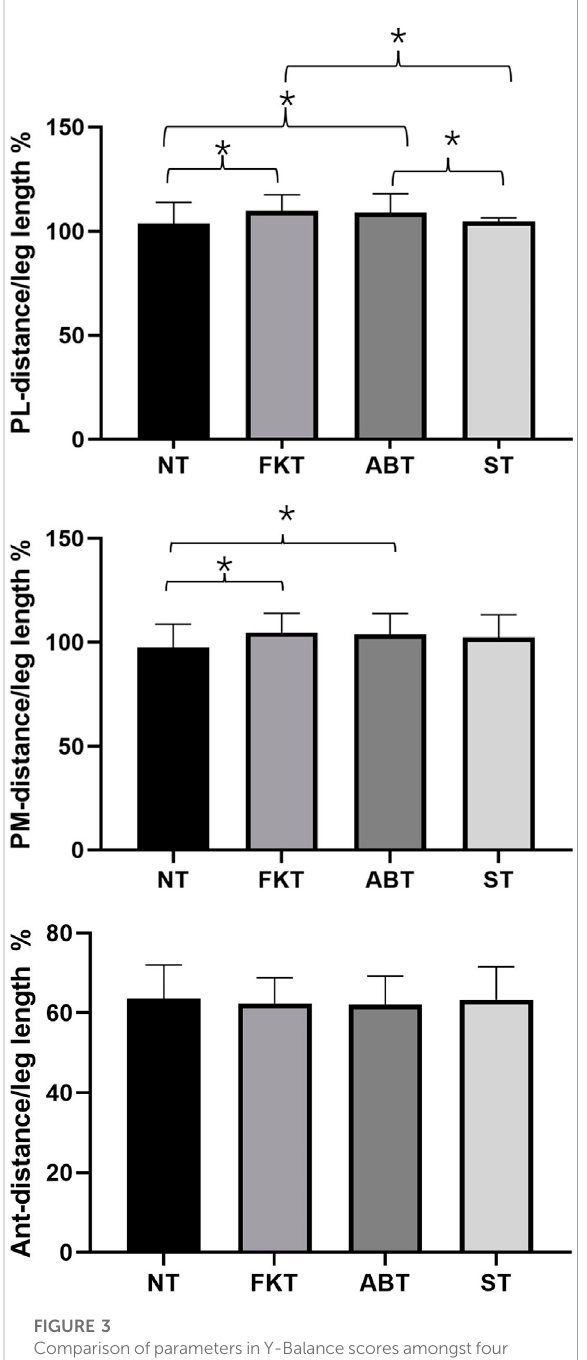
FIGURE 3 Comparison ofparametersinY-Balancescoresamongstfour taping treatments. * p < 0.05, Ant, anterior; PL, posterolateral; PM,